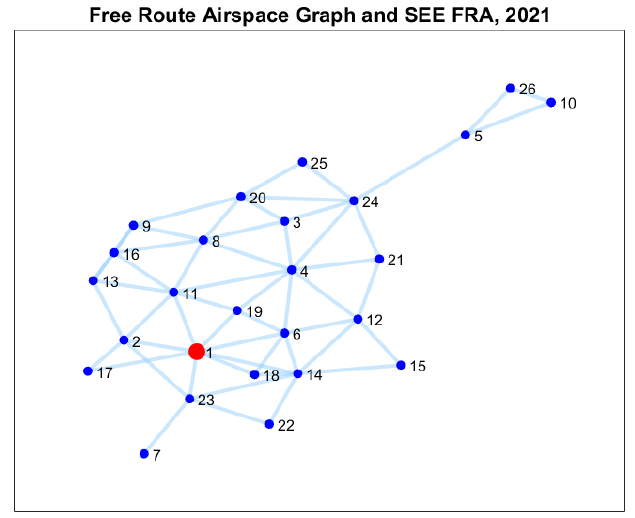
Figure 3. Graph Free Route Airspace,